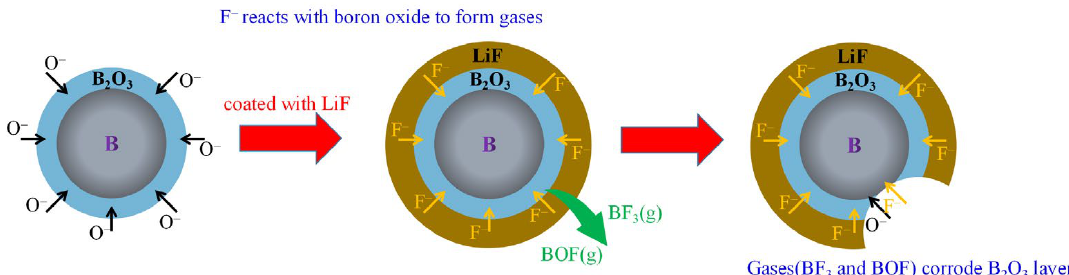
Figure 10. The reaction mechanism of B@LiF.